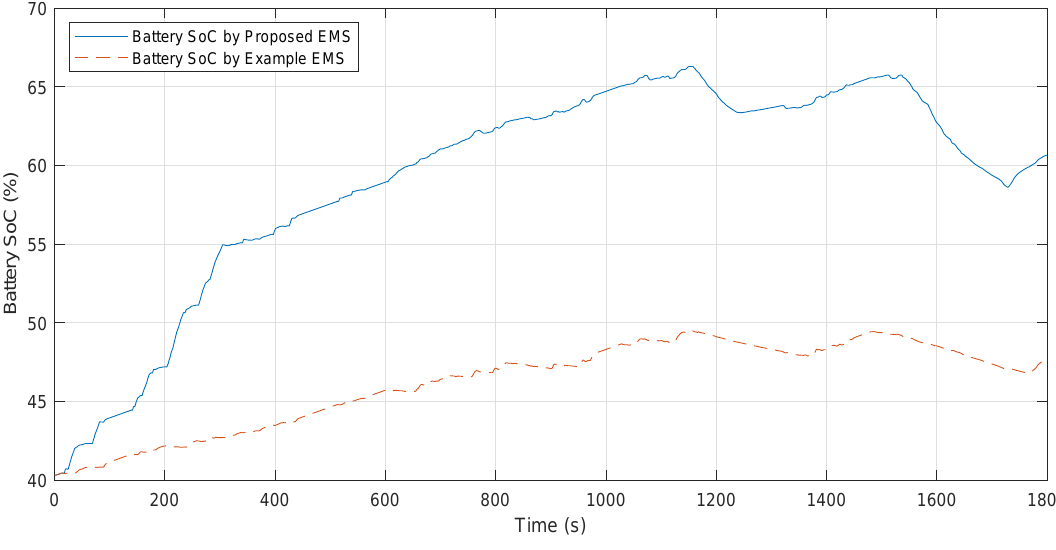
Figure 18. Comparison of battery State of Change